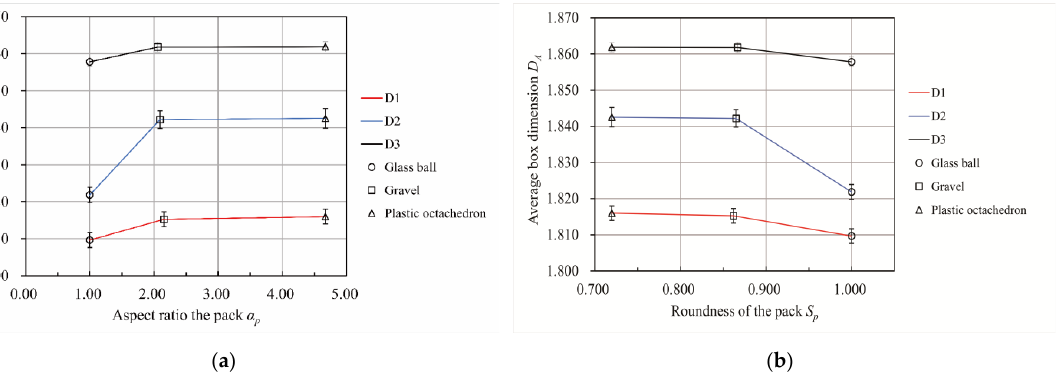
Figure 12. The relationship between the particle pack shape and the average box dimension of the pore – particle interfaces. The error lines in the figures were based on the standard deviation. ( a ) The relationship between the average box dimension of the pore – particle interface and the aspect ratio of the packs. ( b ) The relationship between the average box dimension of the pore – particle interface and the roundness of the packs.